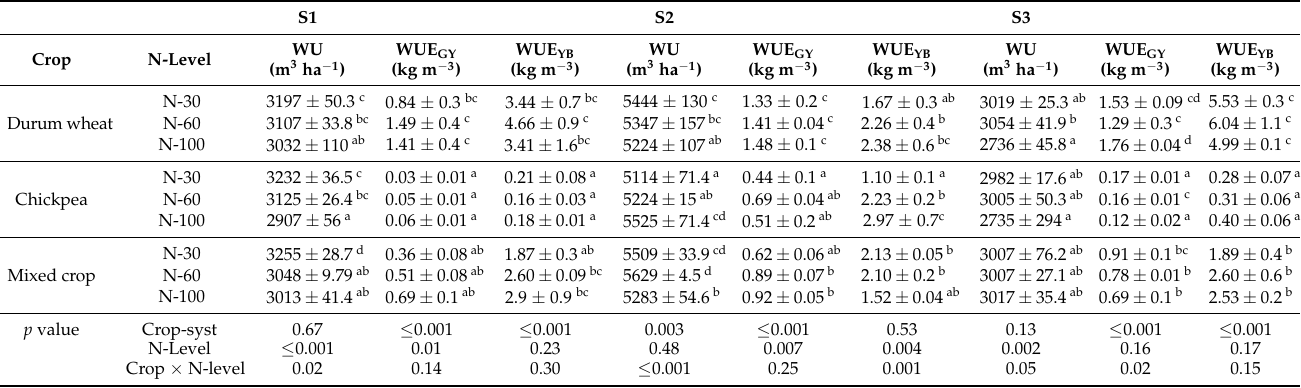
Table 5. Water use (WU), water use efficiency for whole biomass (WUE YB ) and water use efficiency for grain yield (WUE GY ) in chickpea, durum wheat and crop mixture under different crop-N level treatments in the different studied